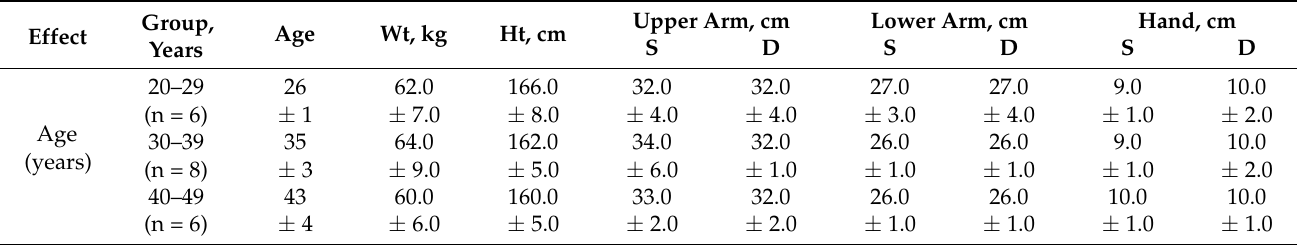
Table 1. Characteristics of the participants by age (values given as average ± STD; S: supporting arm; D: dominant arm; Wt: weight; Ht: height). Effect